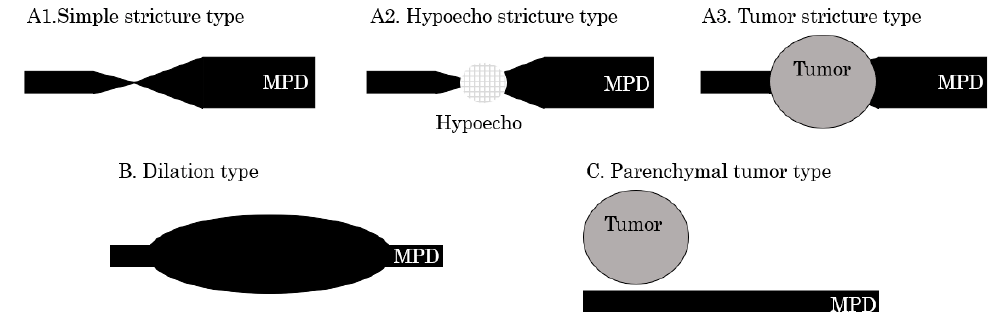
Figure 1. Classification of endoscopic ultrasonography (EUS) findings. A1 : Simple stricture type—a main pancreatic duct (MPD) is strictured without any other findings; A2 : Hypoecho stricture type—a strictured part is surrounded by a focal hypoechoic area without clear demarcation; A3 : Tumor stricture type—a tumor with clear demarcation is recognized at the strictured part; B : Dilation type—An MPD or a branch duct is dilated without a downstream stricture; C : Parenchymal tumor type—A pancreatic tumor with clear demarcation is located apart from the MPD.